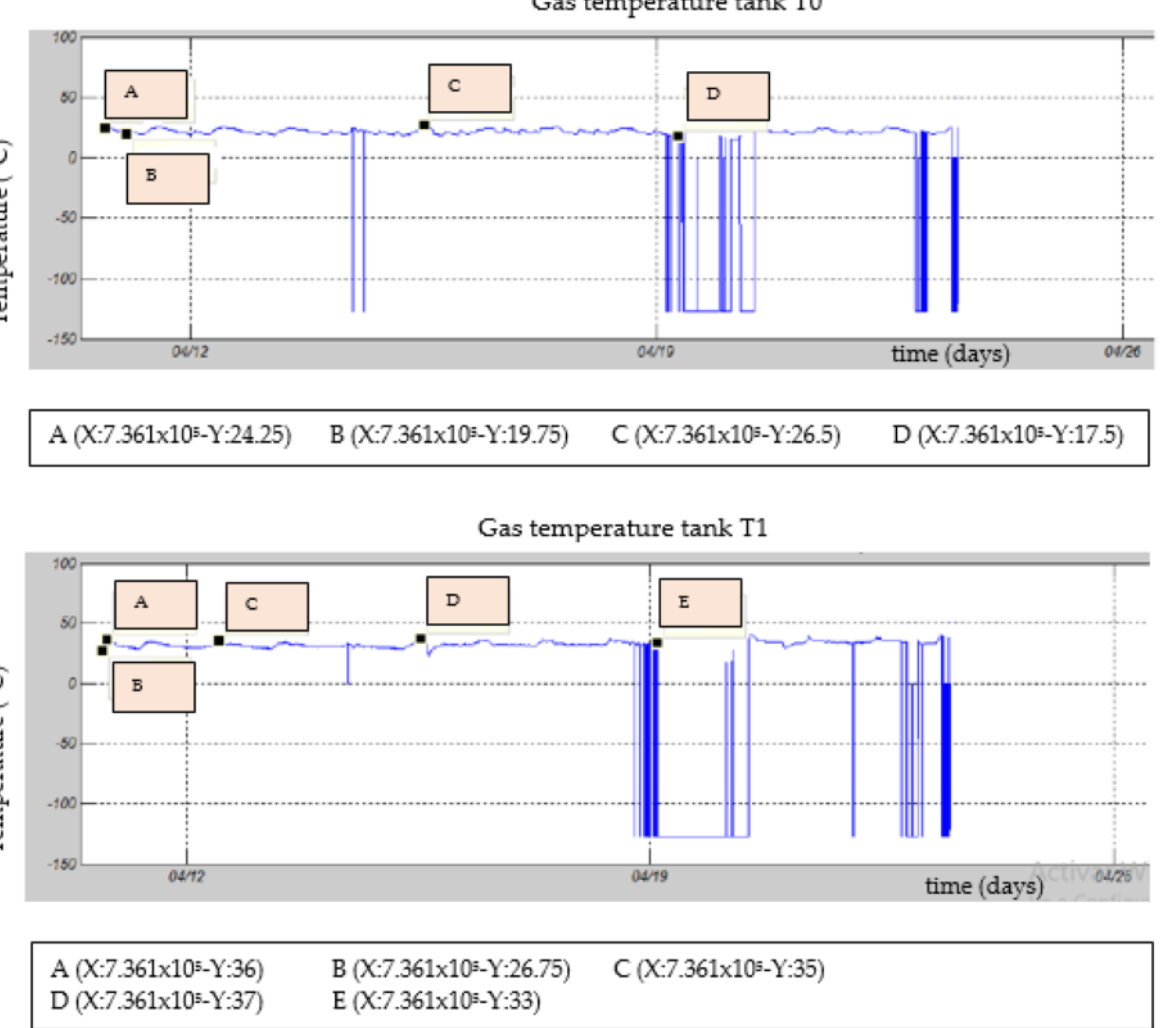
Figure 11. Temperature data for the gas inside the fermentation chamber in both tanks [9].